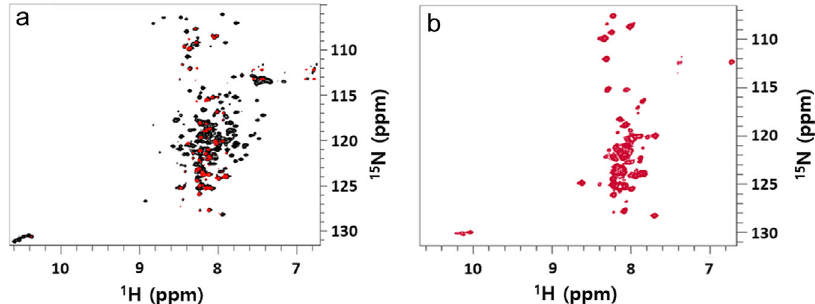
Fig. 4 Identi fi cation of dynamic protein regions. Relaxation NMR experiments: a 1 H- 15 N TROSY-HSQC spectrum (black) of 300 µ M 13 C- 15 N-labeled Bcl-2 in 5 mM DPC micelles at 310 K, with overlaid 1 H- 15 N TROSY-HSQC spectrum (red) using 15 N T 2 relaxation fi ltering (410ms CPMG delay). b 1 H- 15 N TROSY-HSQC spectrum of 270 µ M 13 C- 15 N-labeled Bcl-2 in 0.05% (w/v) Brij-35 micelles at 298 K and at a 1 H frequency of 850 MHz. Signals from fl exible loop region residues are visible in red ( a ) and are the only visible signals in ( b